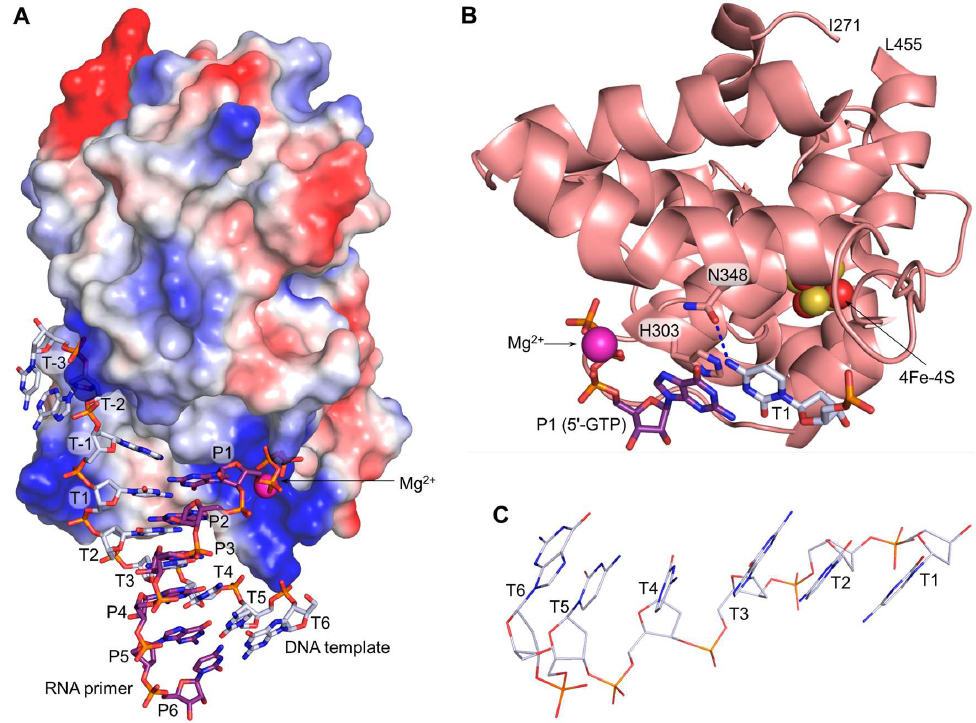
Figure 3. Interaction of p58 C with a DNA template primed by RNA. ( A ) p58 C specifically recognizes the DNA:RNA junction at the primer 5′-end containing the triphosphate. The p58 C surface is represented by the vacuum electrostatic potential at 20% transparency; ( B ) mechanism of p58 C specificity to a purine at the initiation site. The hydrogen bond is depicted by dashed blue line; ( C ) DNA template bends between T3 and T4. All parts of the figure were drawn using the coordinates of the p58 C /DNA:RNA complex (PDB ID 5F0Q).